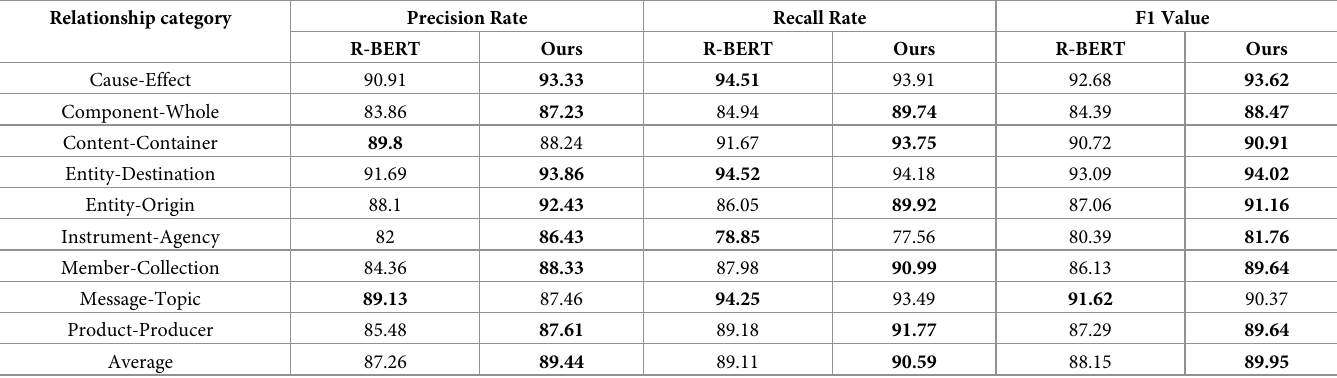
Table 7. Comparison of R-BERT and proposed